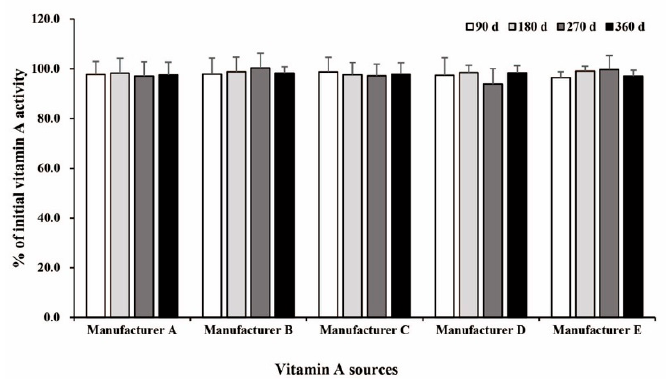
Figure 2. Mean (± standard deviation), n = 6 per treatment group. Effects of storage time and vitamin A source on residual vitamin A activity (% of initial) in vitamin premixes for weanling pigs. The p values relate to vitamin premix (time × source, NS; time, NS; source, NS). NS represents not significant.